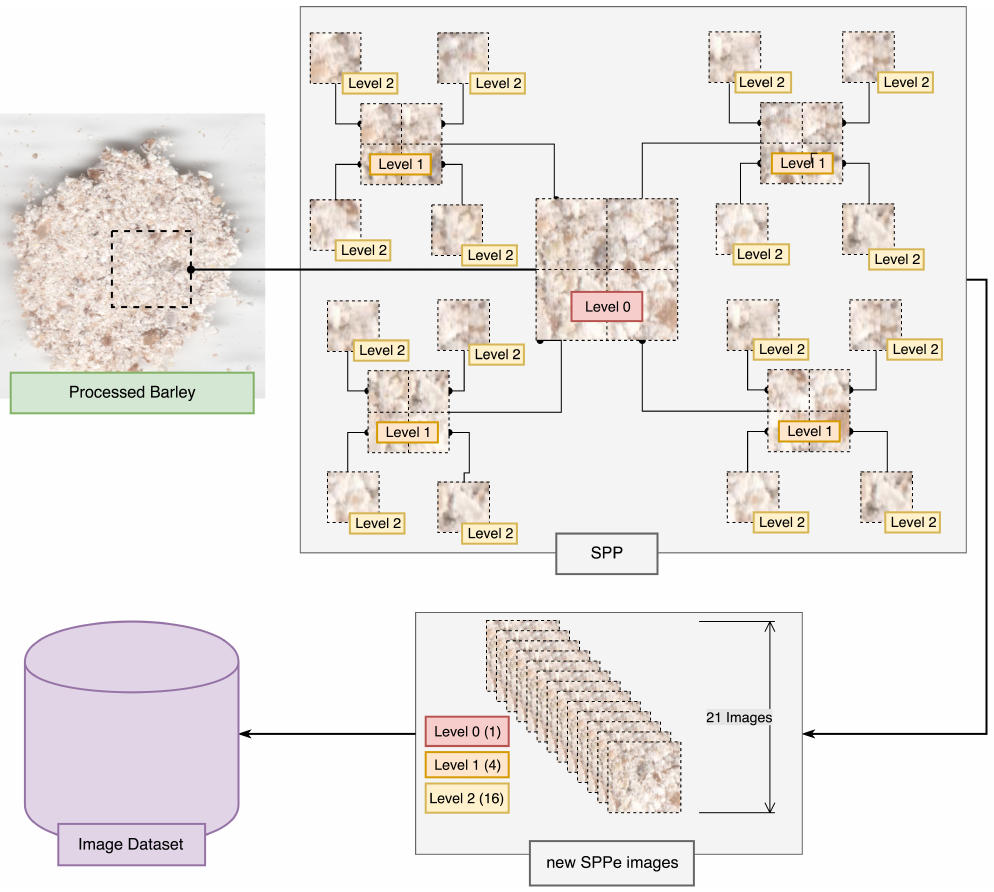
Figure 4. Spatial Pyramidal Partition ensemble (SPPe) for obtaining image